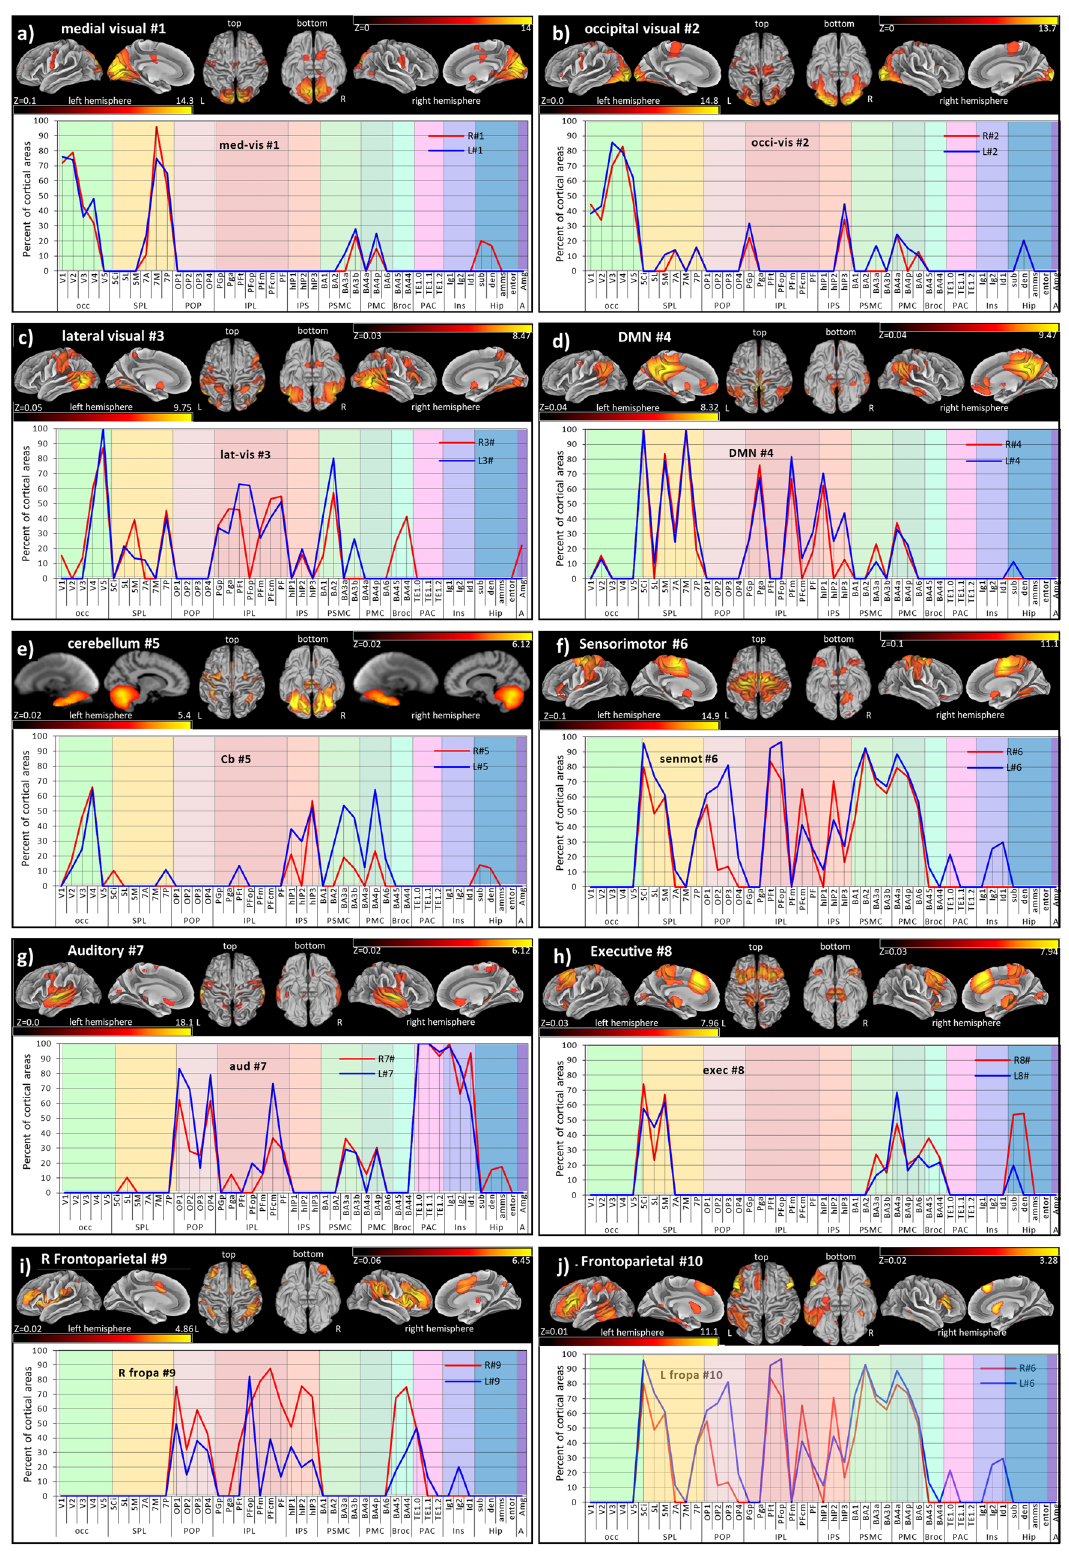
Fig. 1 Cytoarchitectonic Characterization of Smith-10 brain maps. Surface views (top) and plotted percent overlap (bottom) of cortical areas according to the Jülich Histology atlas (bottom), which covered ≥ 10%. The X -axis depicts the cortical areas within the Jülich atlas. For Abbreviations: see Supplementary Table 1 (which includes all overlaps). The Y -axis indicates the percent overlap of the functional network with the atlas labels in the Jülich atlas. The color scale ( z ) of the visualized RSN aligned brain maps: a MV: Left, 0.1 – 14.3 right 0 – 14; b OV: Left, 0 – 14.8 right 0 13.7; c LV: Left, 0.05 – 9.75 right 0.03 – 8.47; d DMN: Left 0.04 – 8.32, right 0.04 – 9.47; e CB: Left 0.02 – 5.4, right 0.02 – 6.12; f SM: Left 0.1 – 14.9, right 0.1 – 11.1; g AU: Left 0 – 18.1, right 0 – 17; h EX: Left 0.03 – 7.96, right 0.03 – 7.94; i RF: Left 0.02 – 4.86, right 0.06 – 6.45; j LF: Left 0.1 – 11.1, right 0.02 – 3.28.